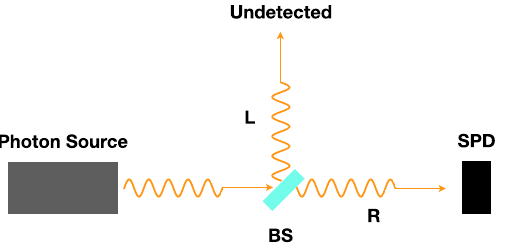
Figure 1. Schematic representation of a single detector setup for generating and measuring superposition state. A single photon is emitted from the source and hits a beam splitter (BS), generating a superposition